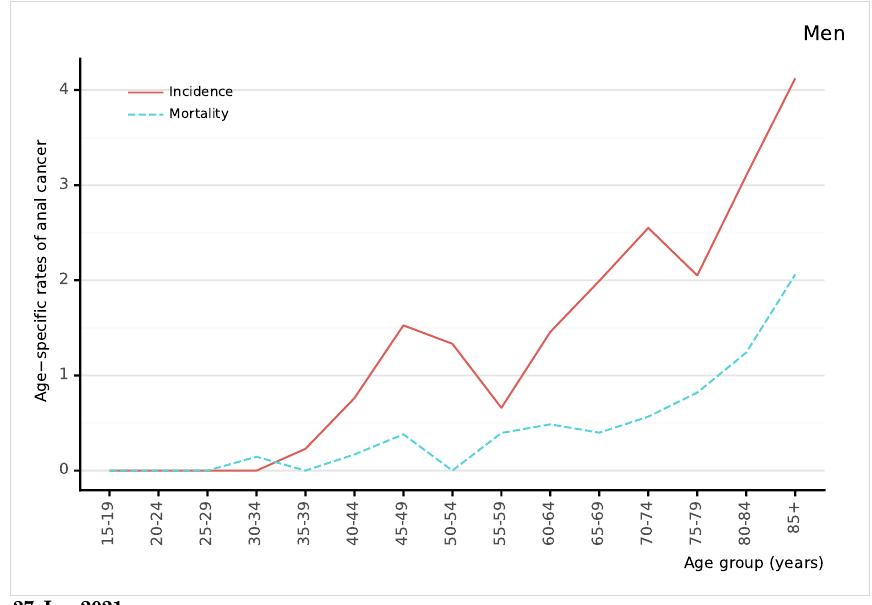
Figure 19: Comparison of age-specific anal cancer incidence and mortality rates among men in Peru